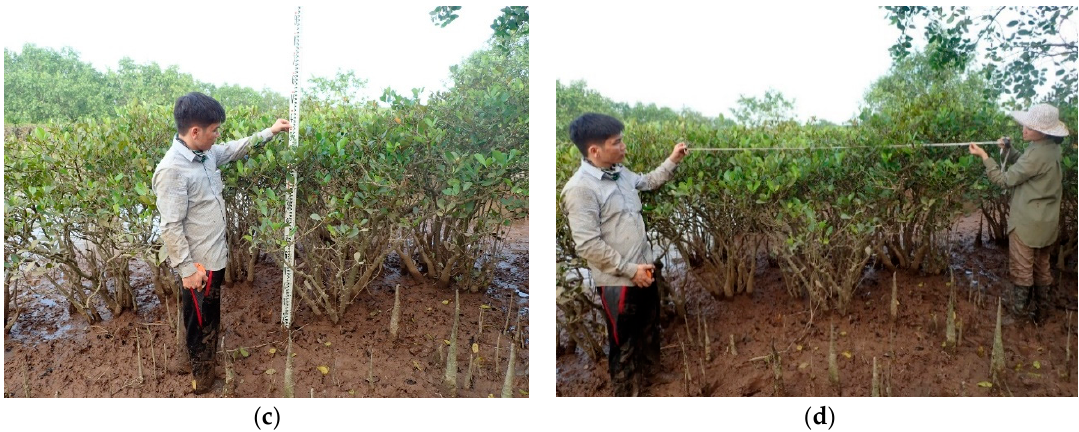
Figure 2. Mangrove AGB measurements of different species in the biosphere reserve: ( a ) and ( b ) biophysical parameter measurements (DBH and H) of tall mangroves and ( c ) and ( d ) crown diameter (CD) measurements of shrub mangrove patches. (Photos were taken by T.D. Pham in November and December of 2018.). The dry AGB for each mangrove species was calculated using the allometric equations.